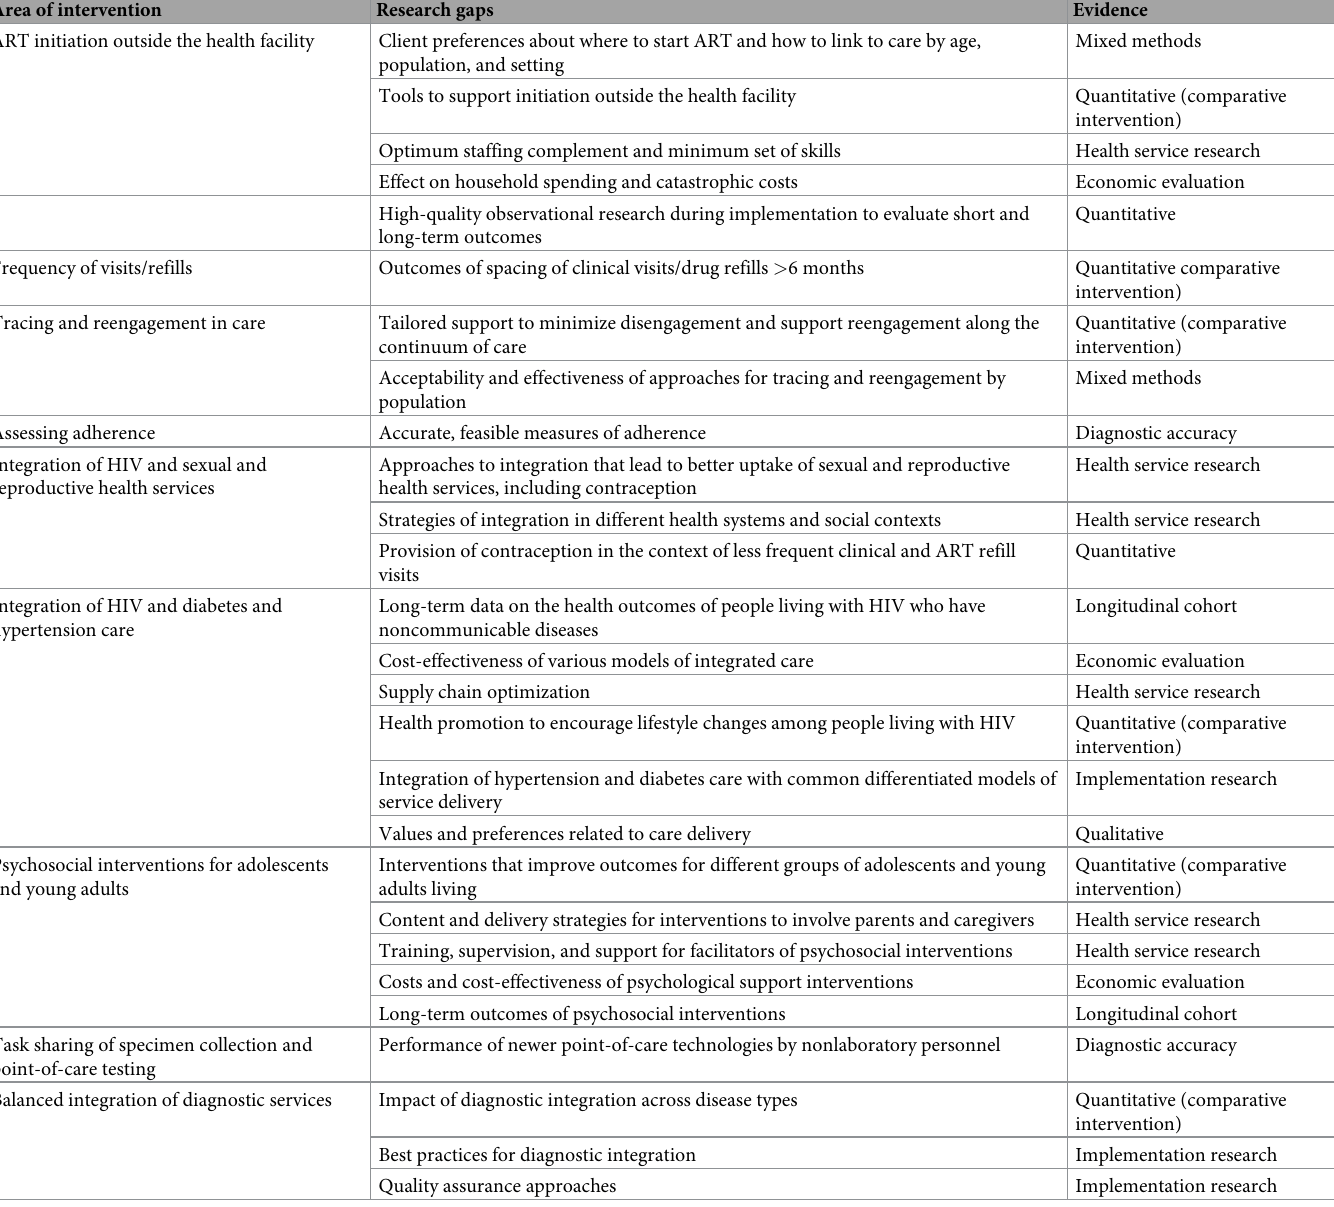
Table 1. Research gaps identified during the HIV service delivery guideline development